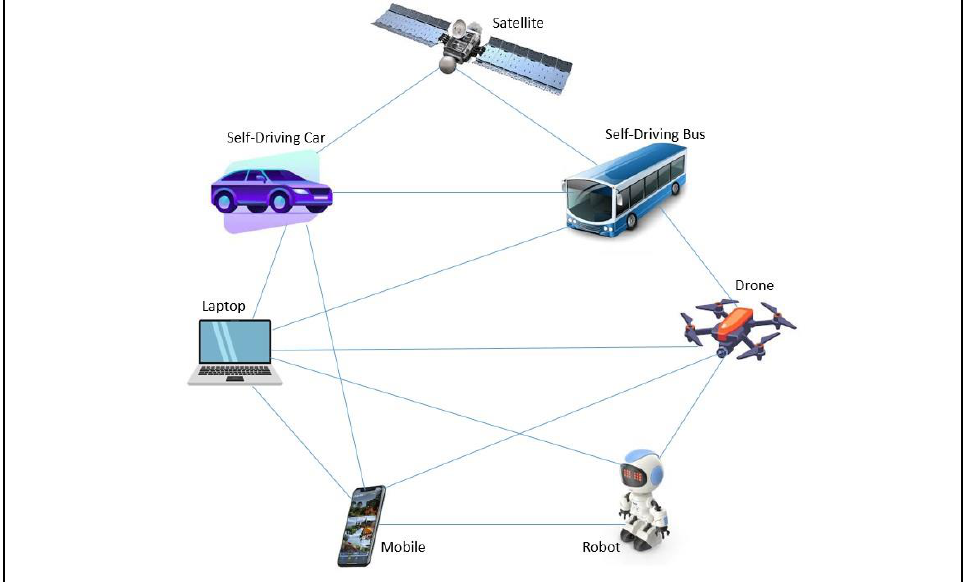
Figure 1. Autonomous device connectivity.